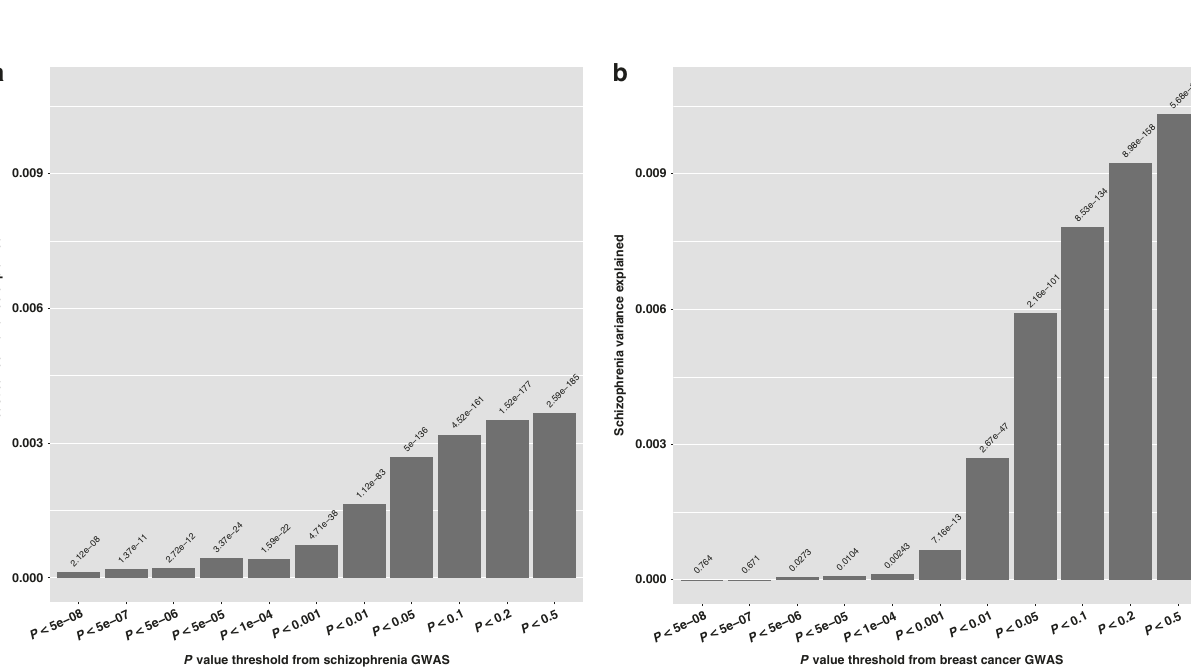
Fig. 1 Genetic association between breast cancer and schizophrenia based on GWAS summary statistics of breast cancer and schizophrenia. a PRS for schizophrenia associated with risk of breast cancer. b PRS for breast cancer associated with risk of schizophrenia. We performed PRS analysis based on GWAS summary statistics. We plotted the variance of one disease ( Y axis) explained by the genetic markers associated with the other disease under a P value threshold ( X axis). The number above the bar indicates the statistical signi fi cance of the genetic association (two-sided P value). GWAS genome- wide association study, PRS polygenic risk